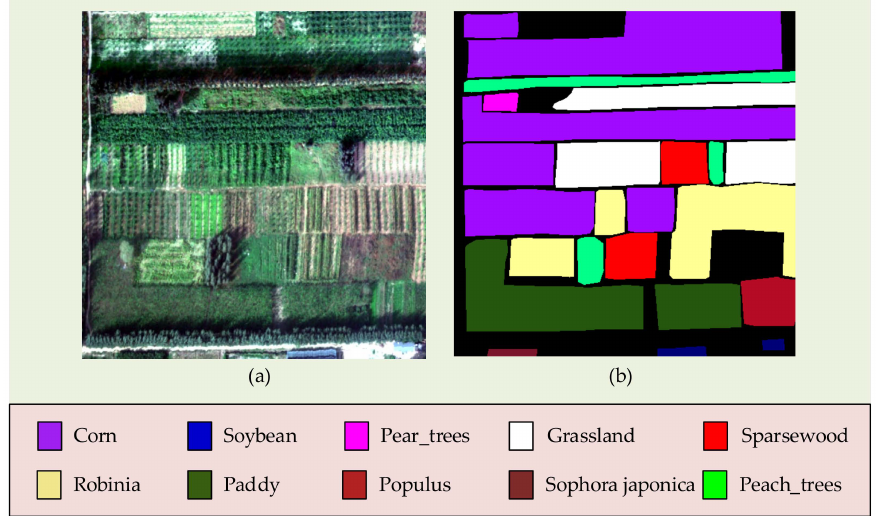
Figure 3. ( a ) original Xiong’an image; ( b ) ground reference map of Xiong’an.